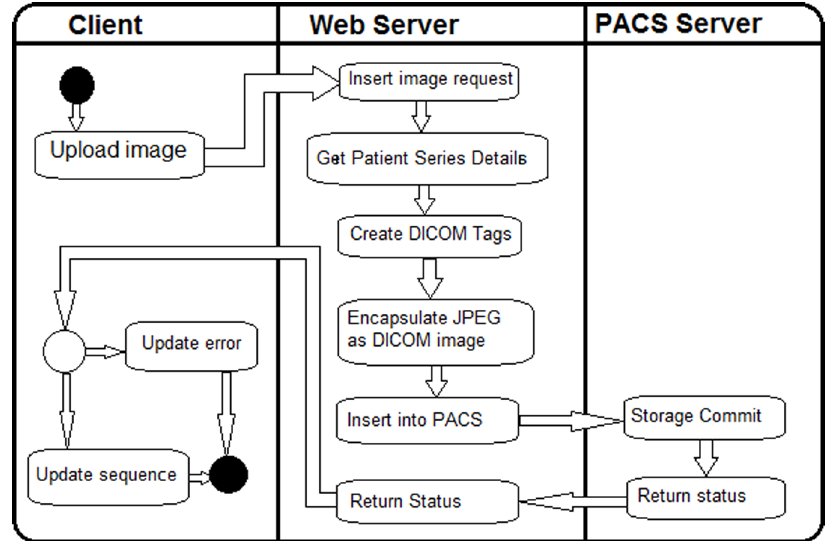
Figure 2. Workflow in the ReMIT system.